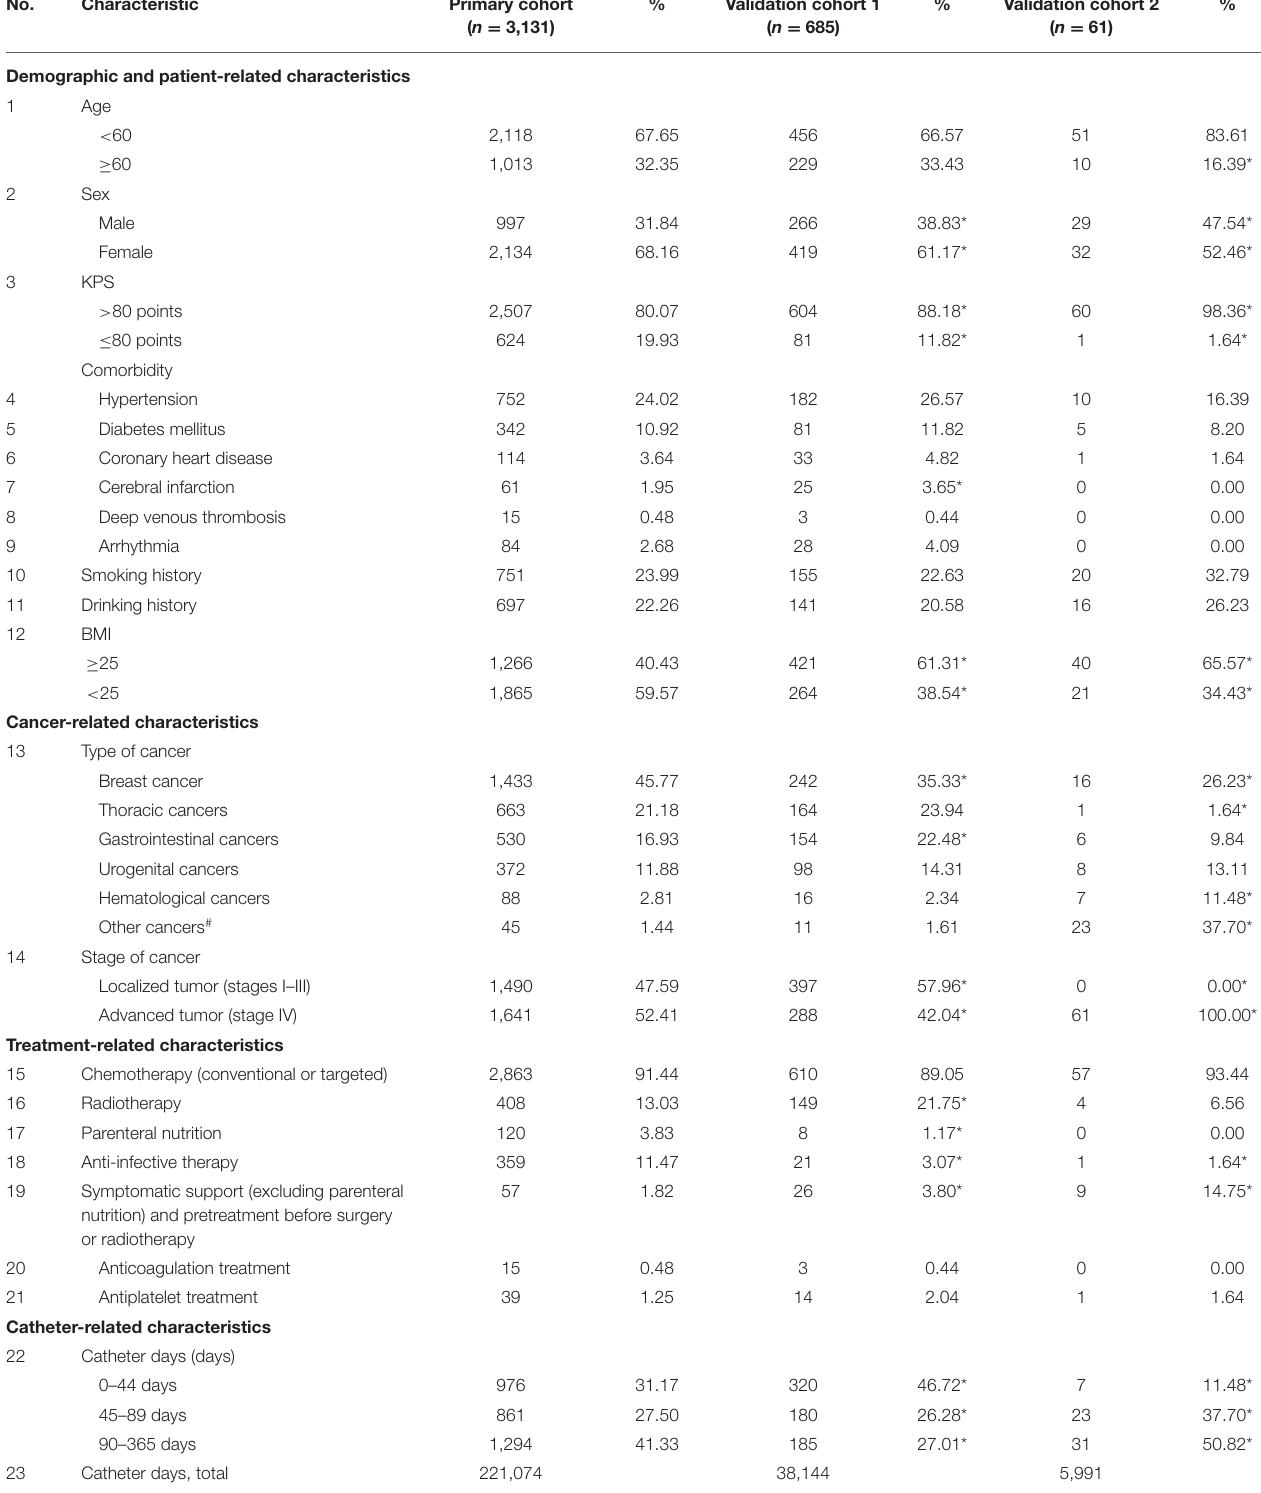
TABLE 1 | Baseline patient